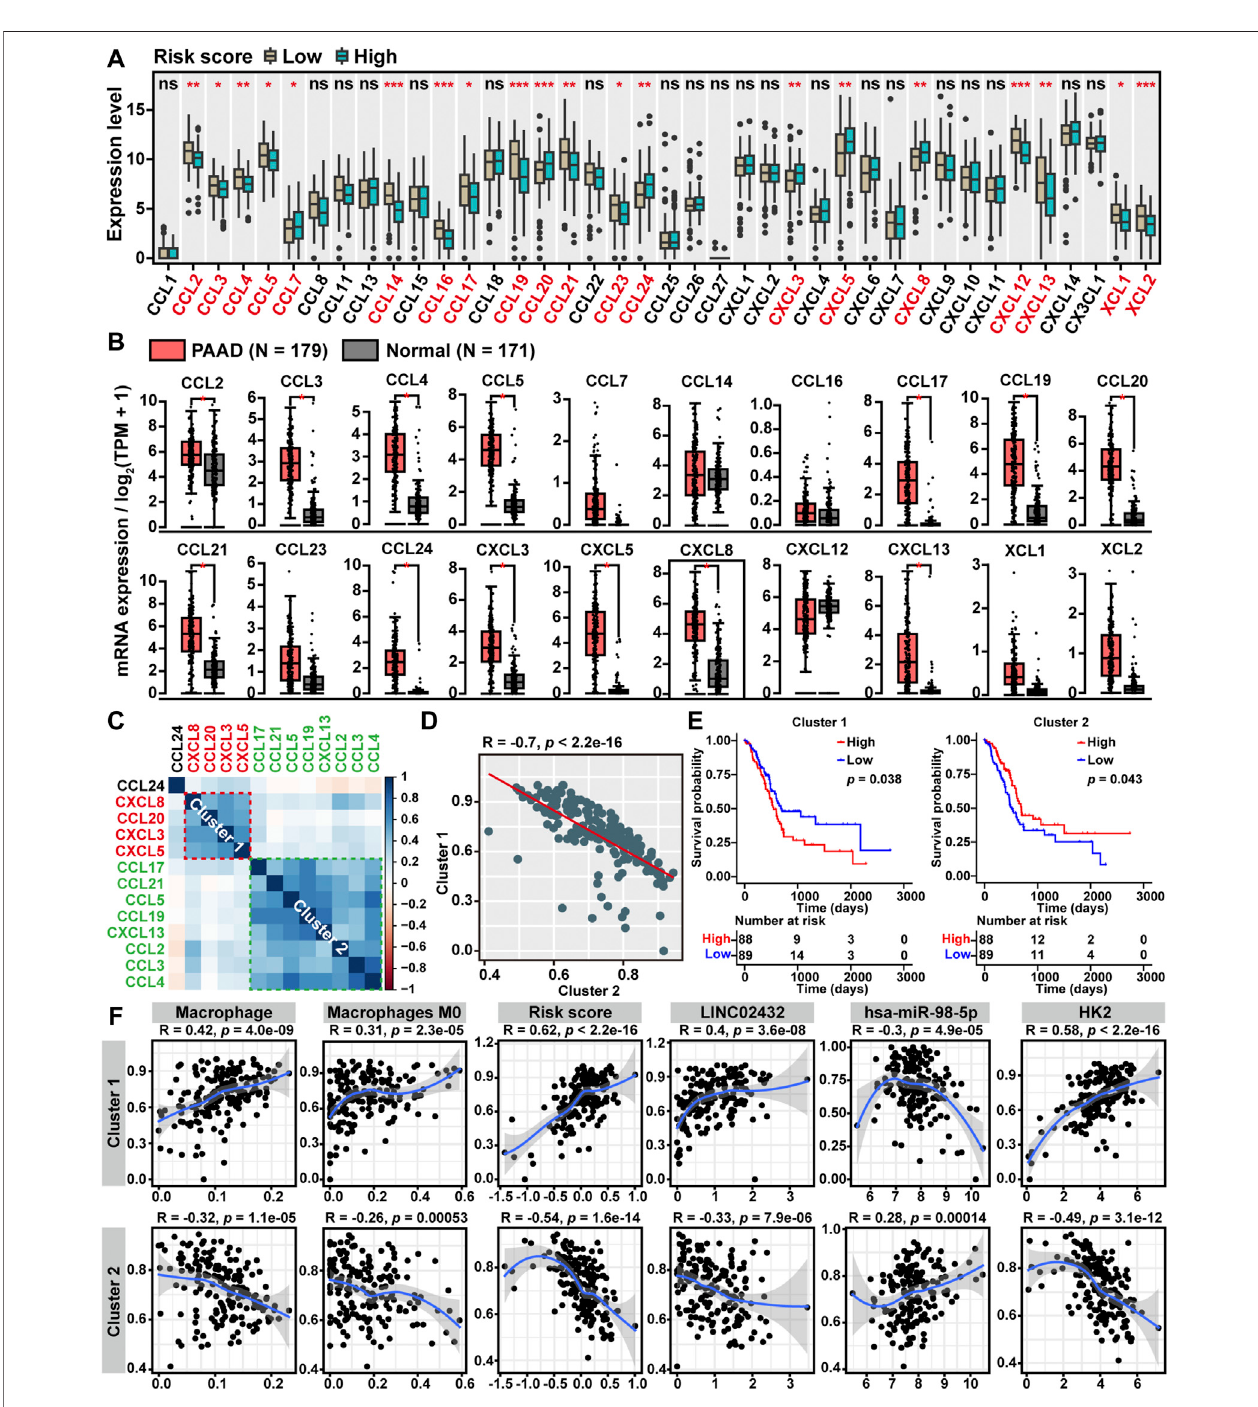
FIGURE6| CorrelationbetweenceRNAriskscoresandchemokinelevels. (A) Theboxplotsshowedtheexpressiondifferencesof40chemokinesamonghighrisk score and low risk score groups of TCGA-PAAD patients. (B) The box plot revealed the expression levels of chemokines between PAAD tissues and normal tissues by the GEPIA2 tool. (C) The clustered heatmap showed the Pearson correlation of 13 differentially expressed chemokines. (D) The Pearson correlation analysis of two chemokine clusters based on the ssGSEA scores. (E) The Kaplan-Meier curves of PAAD overall survival based on the ssGSEA scores of two chemokine clusters. (F) The Pearson correlation analysis of two chemokine clusters with LINC02432/hsa-miR-98 – 5p/HK2 ceRNA network and macrophages in fi ltration levels.